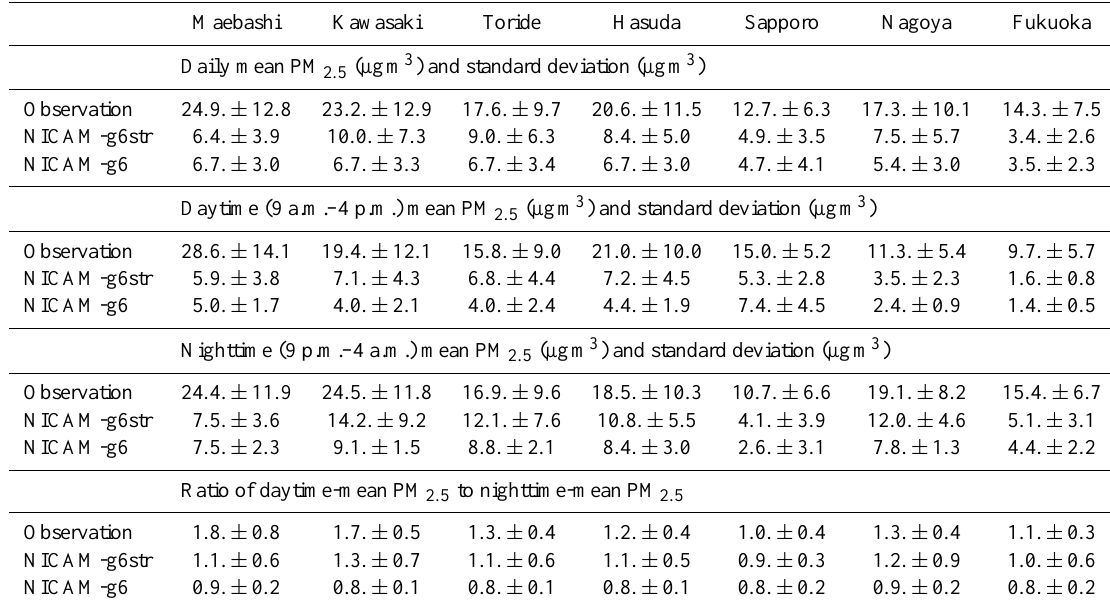
Table 3. PM 2 . 5 concentrations in daily, daytime (from 9 a.m. to 4 p.m.), and nighttime (from 9 p.m. to 4 a.m.) averages and mean ratios of daytime to nighttime using the simulations (NICAM-g6str and NICAM-g6) and the observation at seven selected sites in August. Maebashi Kawasaki Toride Hasuda Sapporo Nagoya